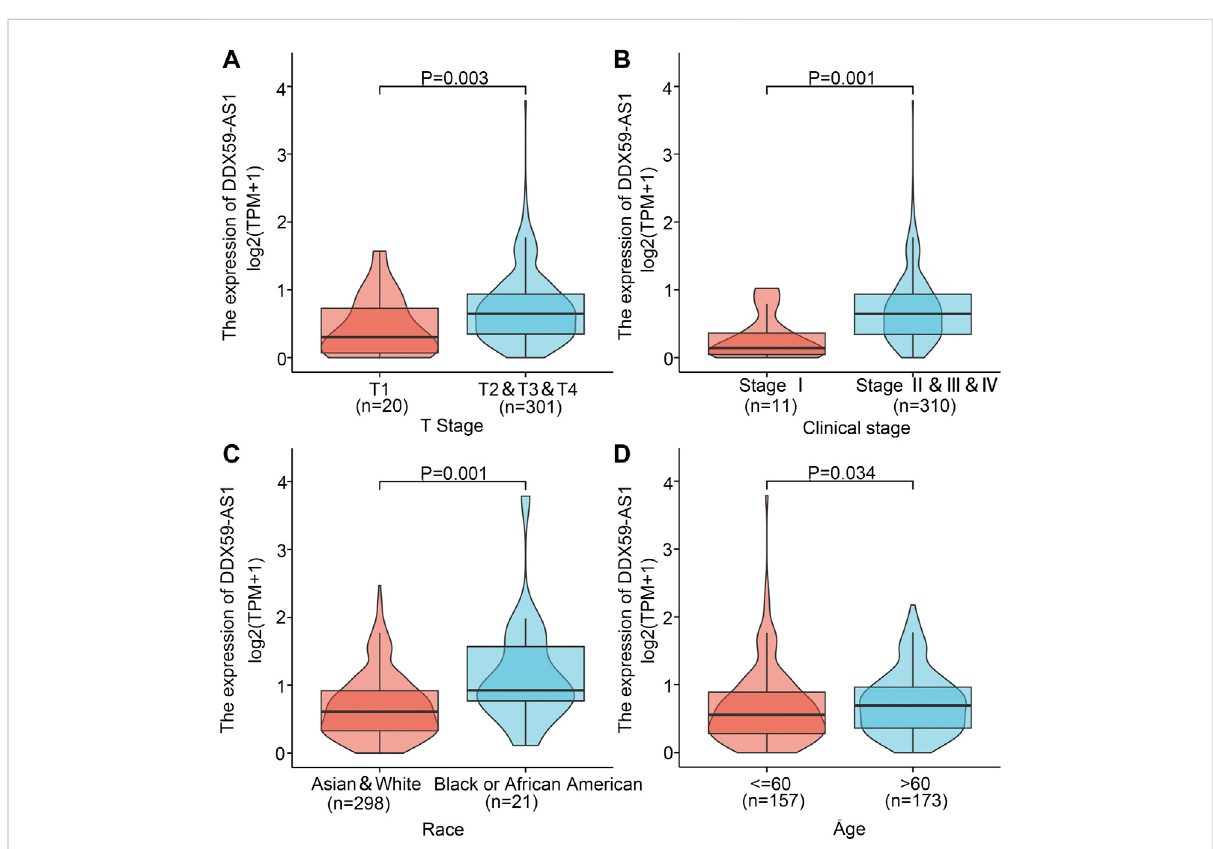
FIGURE 4 Association of DDX59-AS1 expression with clinicopathologic characteristics. (A) T stage; (B) Clinical stage; (C) Race; (D) Age.